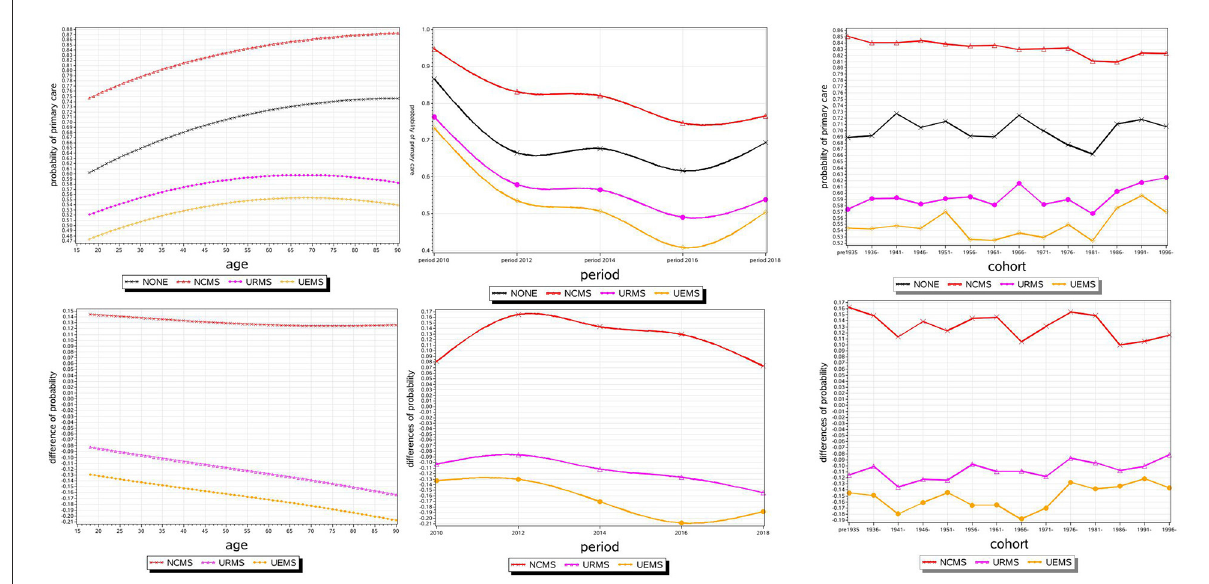
FIGURE1 The effect of basic medical insurance participation on primary care with age, period, and